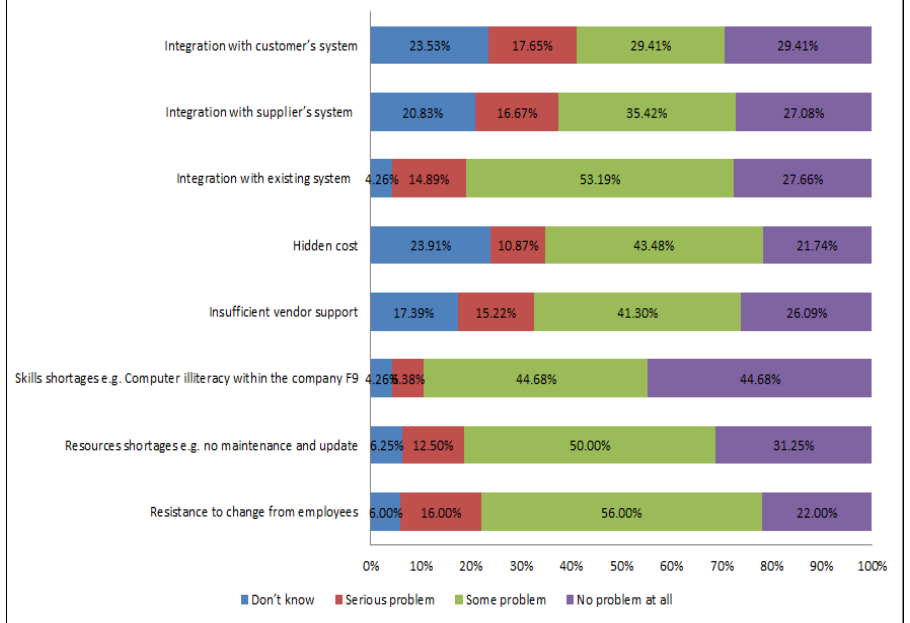
Figure 8. The problems of using